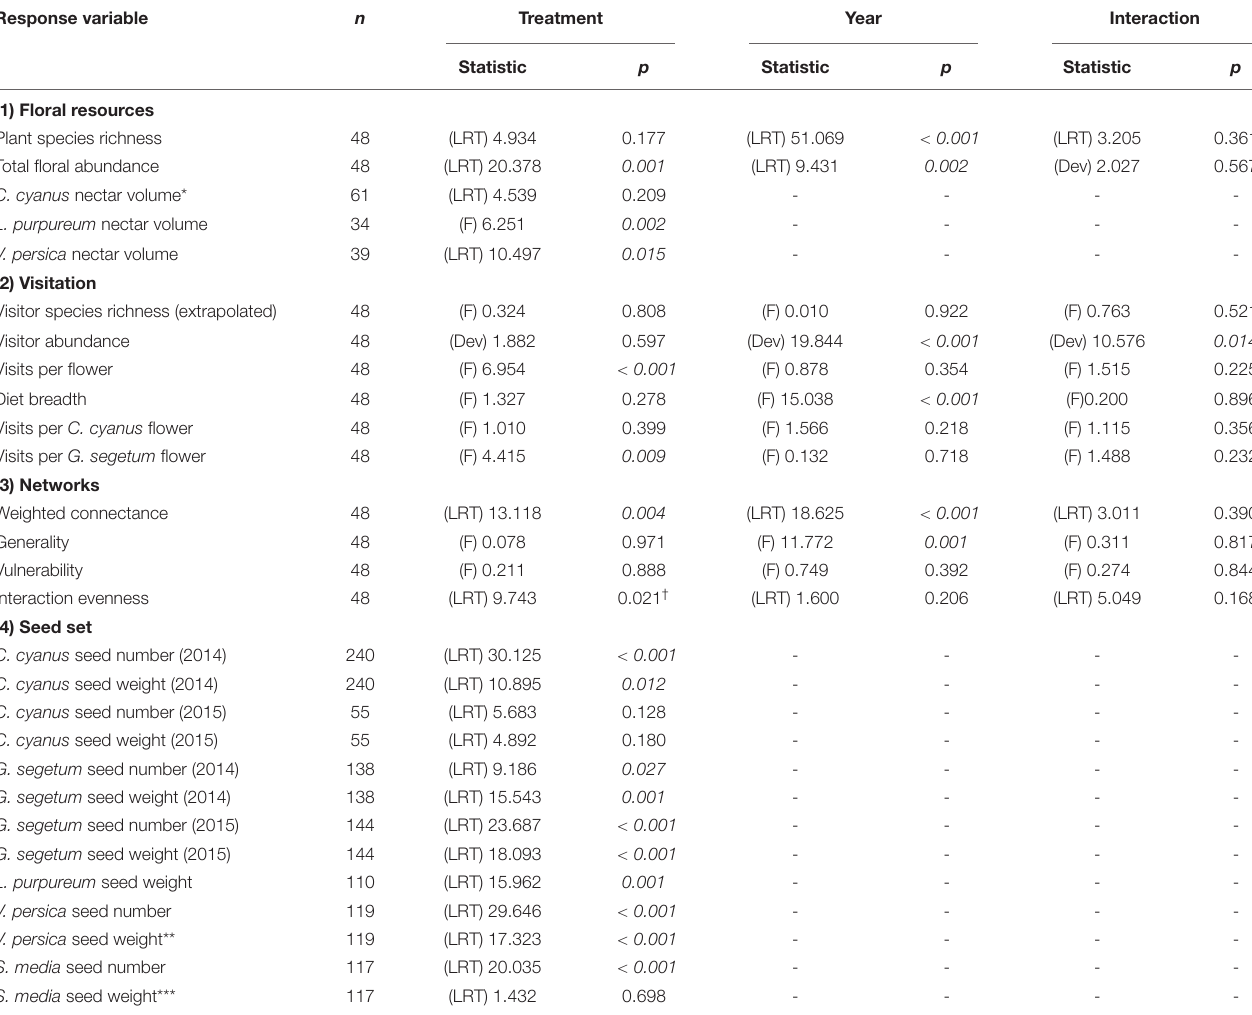
TABLE 1 | Effect of treatment and year on all plant and insect-visitor response variables (d.f = 1 for year, 3 for treatment, 3 for treatment:year interaction). Response variable n